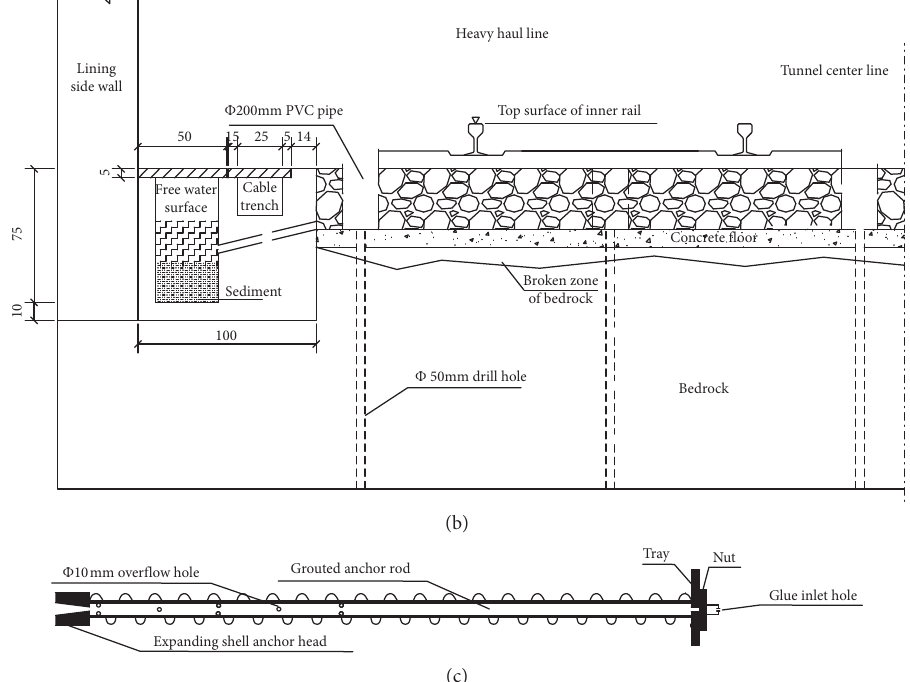
Figure 3: Design of anchoring and grouting of tunnel bottom structure. (a) Plan (b) Section. (c) Section of anchor